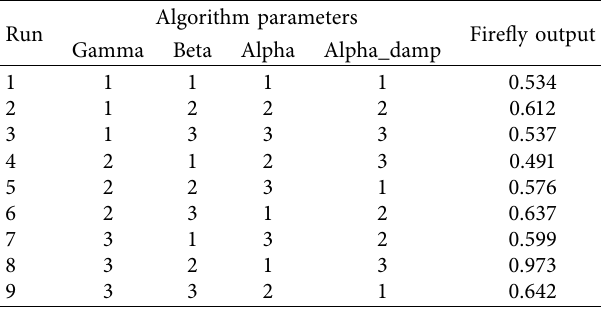
Table 8: Results of design of experiment response. Algorithm parameters